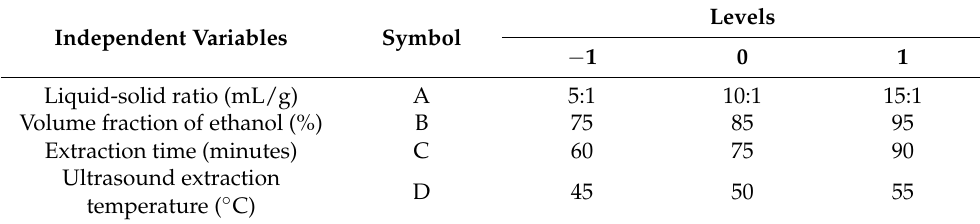
Table 7. Variables and their levels used in the